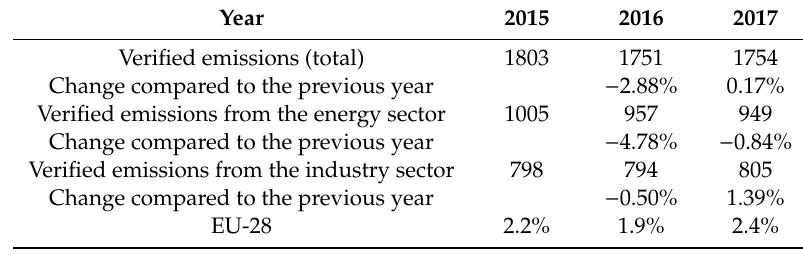
Table 1. Emissions in the EU ETS system in the period 2011–2017 (in million tonnes of CO 2 equivalent).